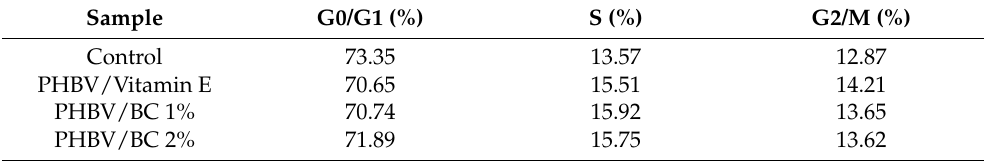
Table 4. Cell cycle distribution (%) of mouse NCTC fibroblasts treated with PHBV/BC-based biocomposites.